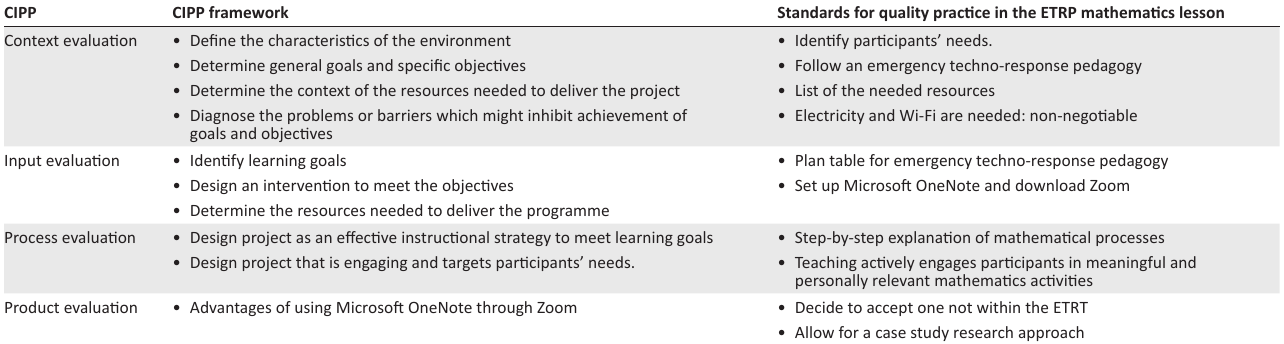
Table 1-A2: The CIPP